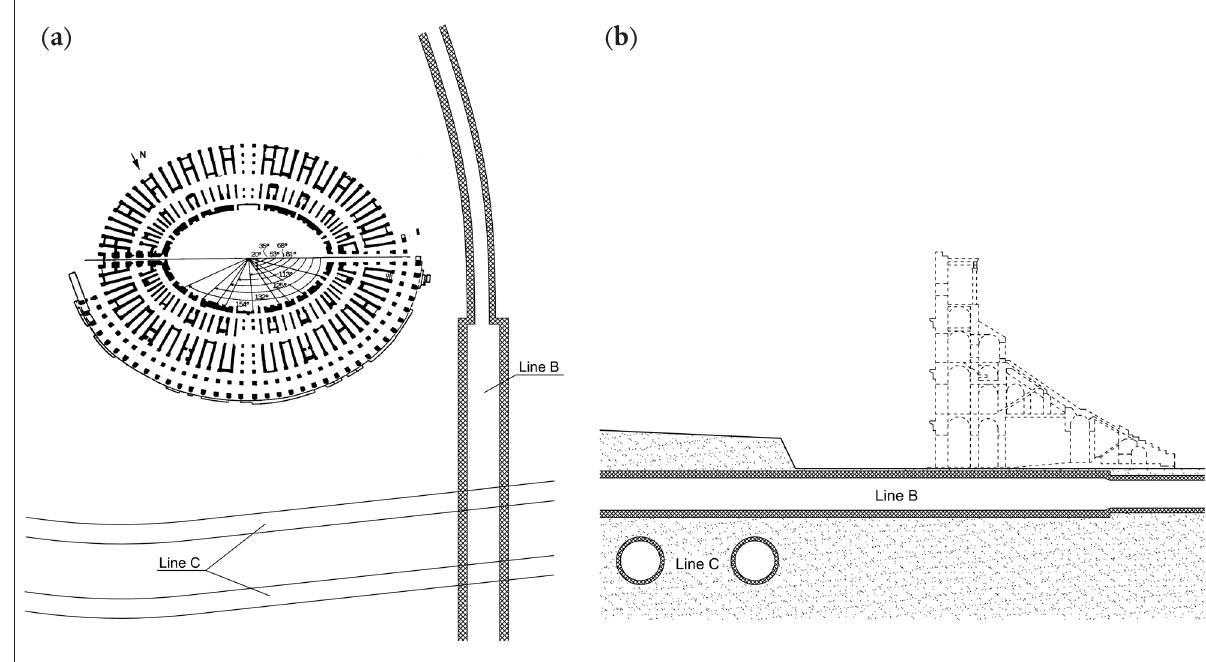
Figure 2. The Colosseum and the underground lines: (a) plan and (b) section.